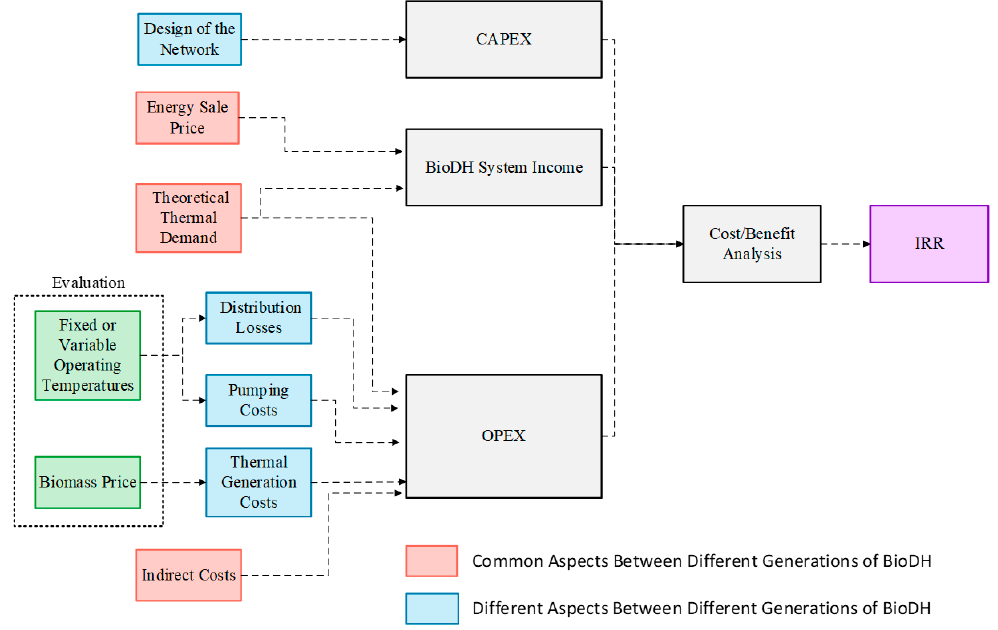
Figure 3. Stage II methodology.